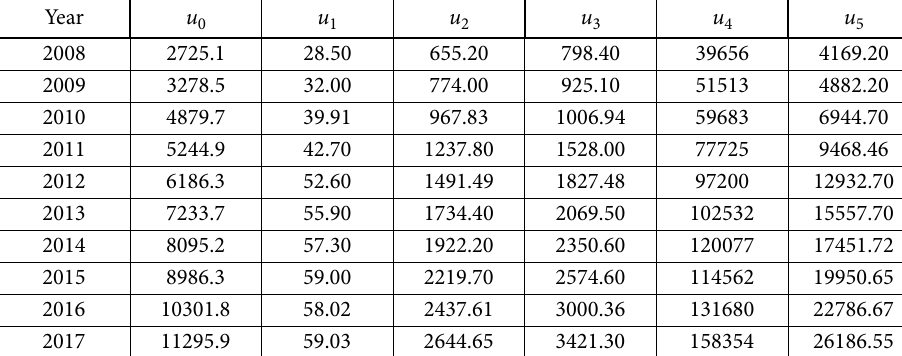
Table 1. Statistics of China’s high-tech industry